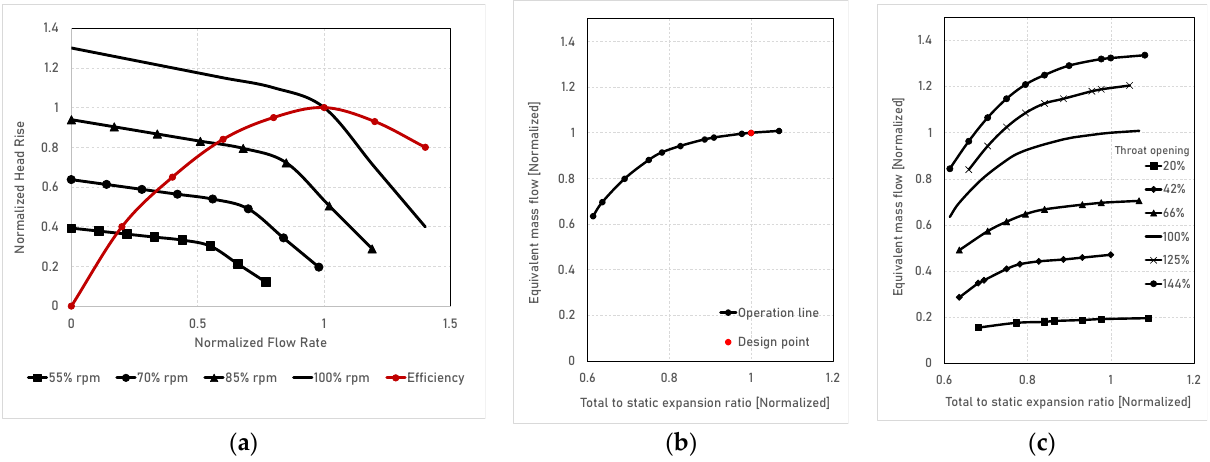
Figure 2. Performance map: ( a ) VFD pump; ( b ) Radial inflow turbine; ( c ) VAN turbine.